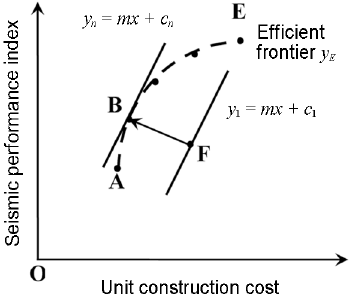
Fig. 5. Benchmark identification